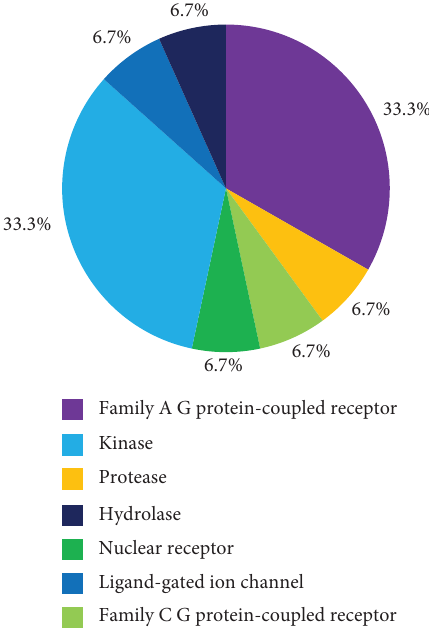
Figure 4: Te components of binding protein of irbesartan. Table 5: Efects of irbesartan in diferent genotype